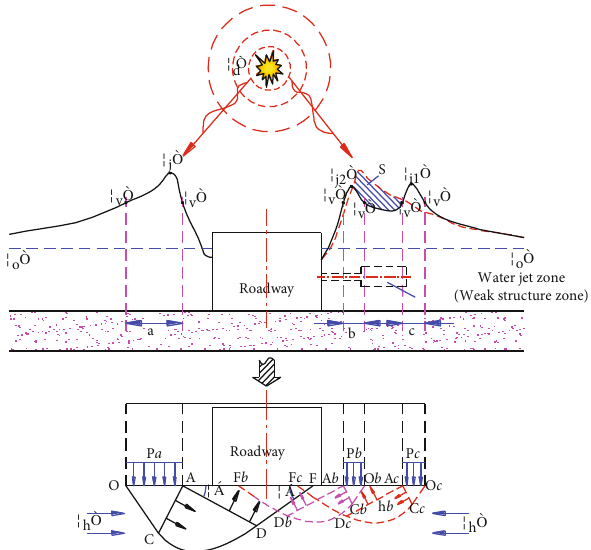
Figure 10: The prevention mechanism schematic diagram of rock burst in roadway fl